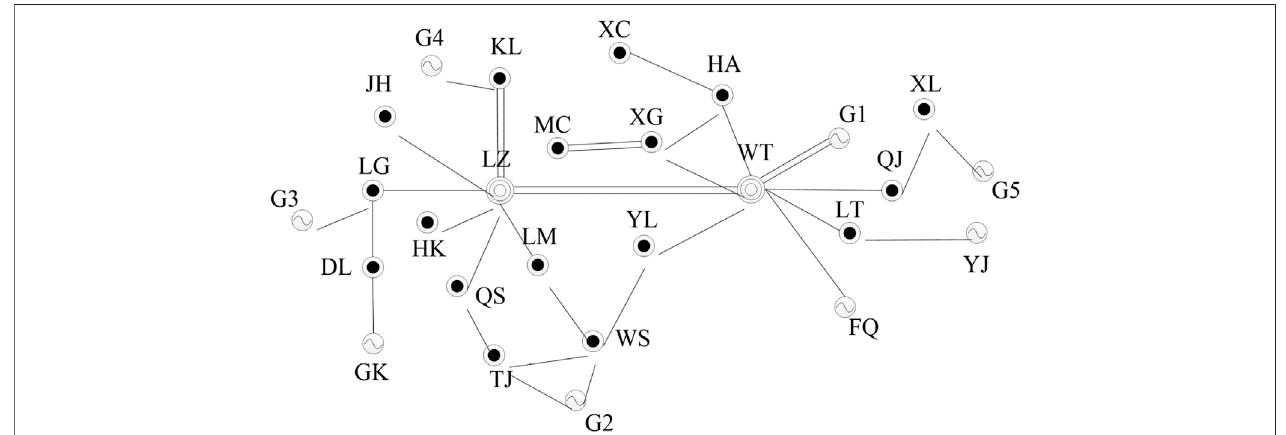
FIGURE 3 | Grid structure diagram.